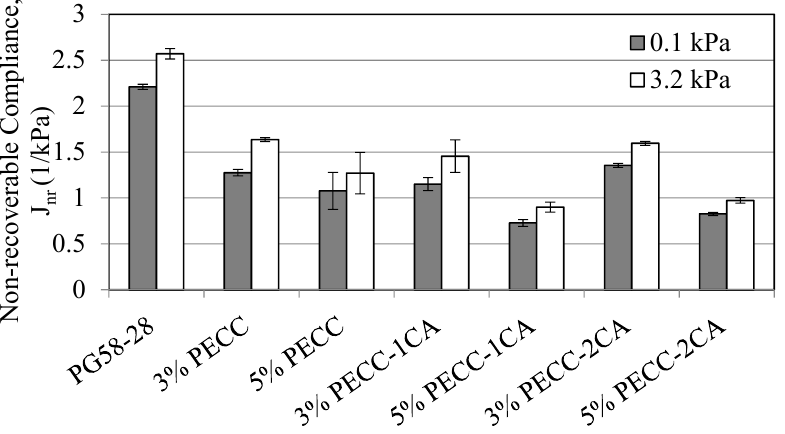
Figure 8. Non ‐ recoverable compliance for evaluation of rutting potential.